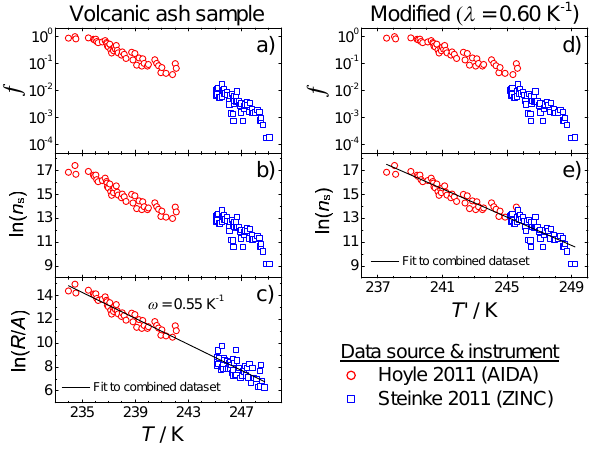
Figure 10. Freezing of droplets containing volcanic ash sampled from the Eyjafjallajökull eruption in 2010. Layout as in Fig. 5. Red circles represent data presented in Hoyle et al. (2011) using the ZINC instrument, and blue squares represent data from Steinke et al. (2011) using the AIDA expansion chamber. n s (T ) data in (b) were reproduced from Murray et al. (2012); f (T ) values in (a) were also determined from this data set. A fit to determined R/A values in (c) resulted in ω = 0.55K − 1 . The raw n s (T ) data were modified by iteratively decreasing λ until n s (T 0 ) values collapsed on a single line, resulting in λ = 0.60K − 1 . The similarity in ω and λ suggests that this volcanic ash sample behaves as a single-component sys-